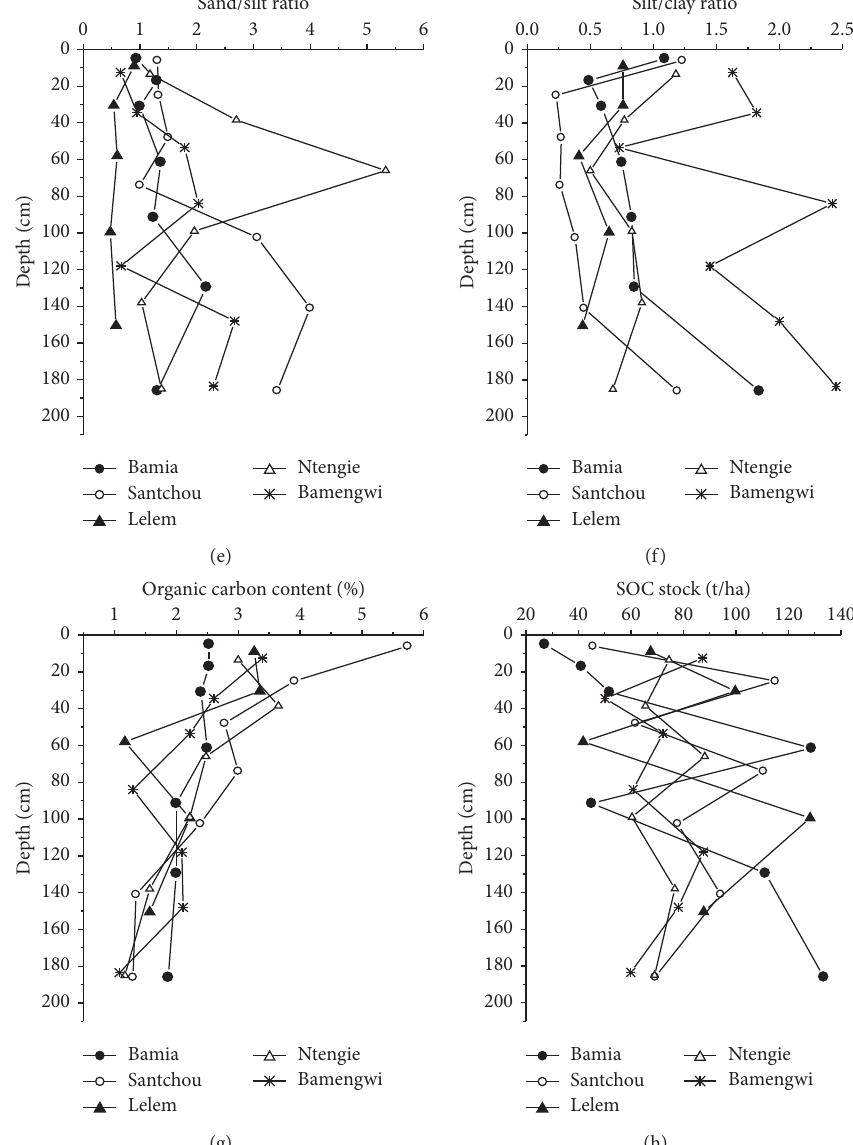
Figure 4: Variation of selected soil physical and chemical properties with